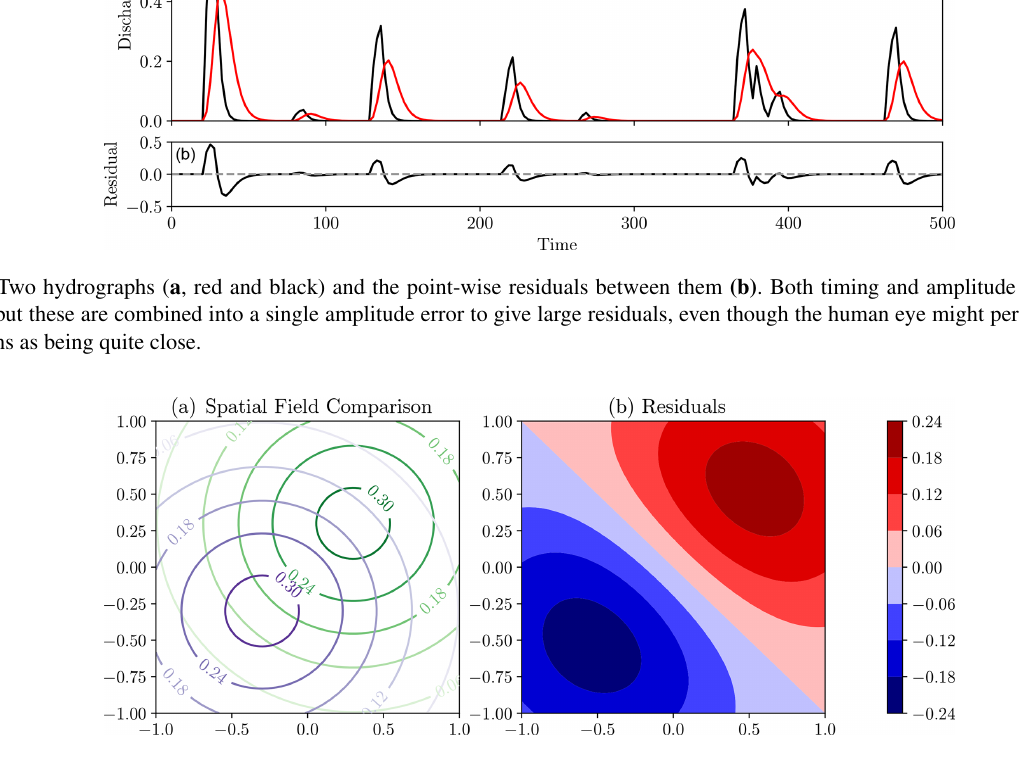
Figure 2. Synthetic example of the comparison of modelled (purple) and observed (green) spatial fields in panel (a) . Panel (b) shows the residuals (green field minus purple field), which display the double-penalty effect as the error is in displacement rather than